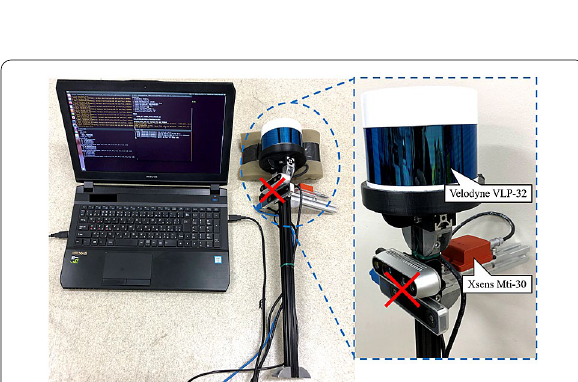
Fig. 3 Sensors installed on stick. Point clouds and acceleration are recorded with this stick when it is still. The judge whether it is static is processed by programing